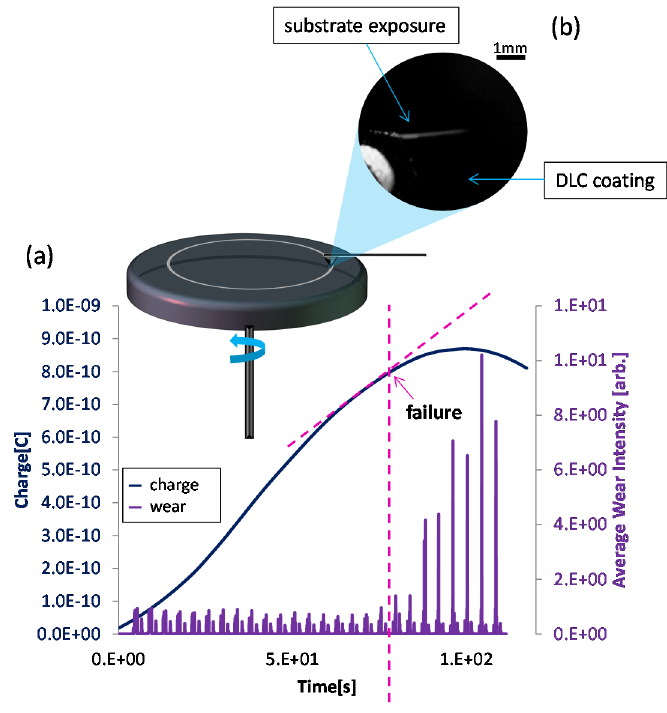
Figure 10. ( a ) Average wear track intensity and surface charge vs. time; ( b ) example of 5× magnification wear track tip outlet.